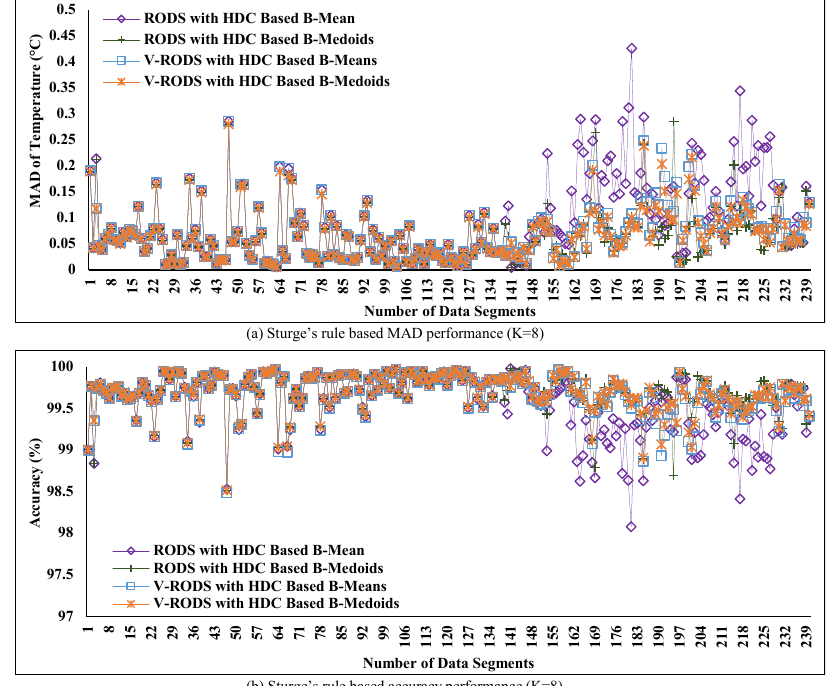
Figure 18. Performance comparison between V-RODS with HDC and RODS with HDC-based techniques versus the number of data segments. ( a ) MAD versus RODS with HDC and V-RODS with HDC-based techniques over time; ( b ) accuracy versus RODS with HDC and V-RODS with HDC-based techniques over time.